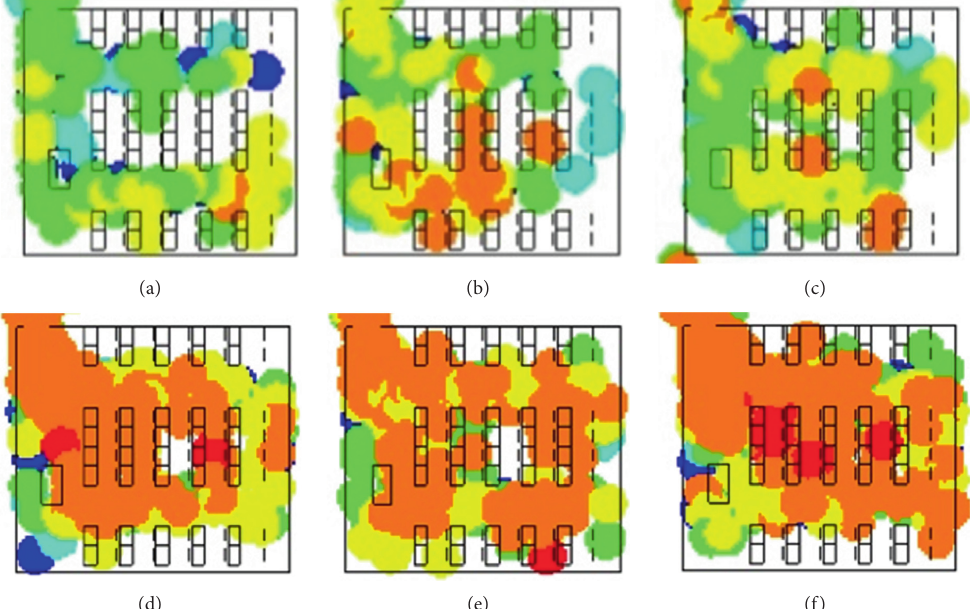
Figure 9: Flow size-based cumulative maximum density under disorderly distribution conditions. (a) 10. (b) 15. (c) 20 (d) 25. (e) 30. (f) 35.